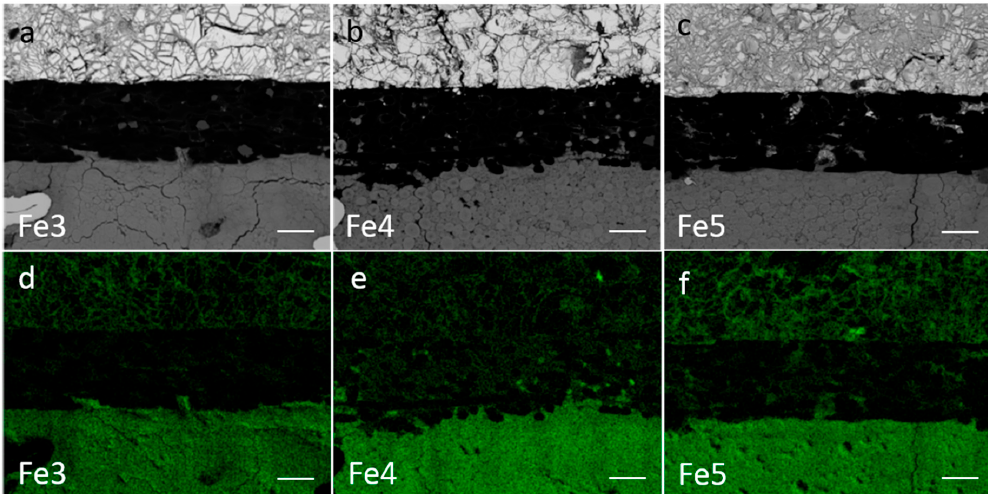
Figure 8. SEM micrographs of the cross-sections of cells ( a ) Fe3, ( b ) Fe4 and ( c ) Fe5 and their corresponding O-EDS elemental mappings ( d ) Fe3, ( e ) Fe4 and ( f ) Fe5 after cycle life testing at RT. The scale bar represents 50 µm. In each figure, the sandwich structure from top to bottom consists of the negative electrode, separator and positive electrode.